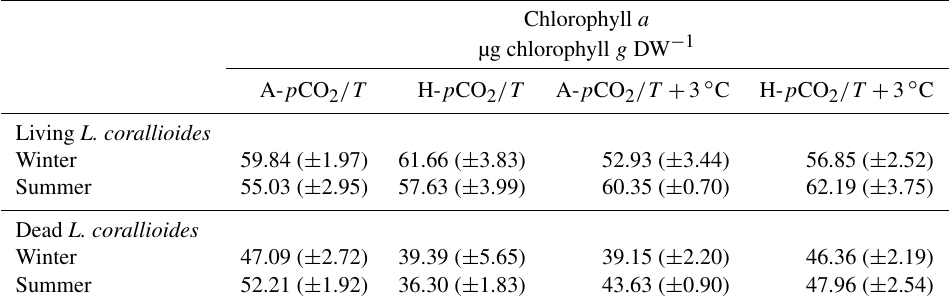
Table 6. Chlorophyll a content (mean ± SE) of living and dead L. corallioides in the different p CO 2 p CO 2 (A- p CO 2 is ambient p CO 2 ; H- p CO 2 is high- p CO 2 ) and temperature ( T is ambient temperature; T + 3 ◦ C is high temperature) treatments, after being maintained for 3 months in winter and summer conditions, n =